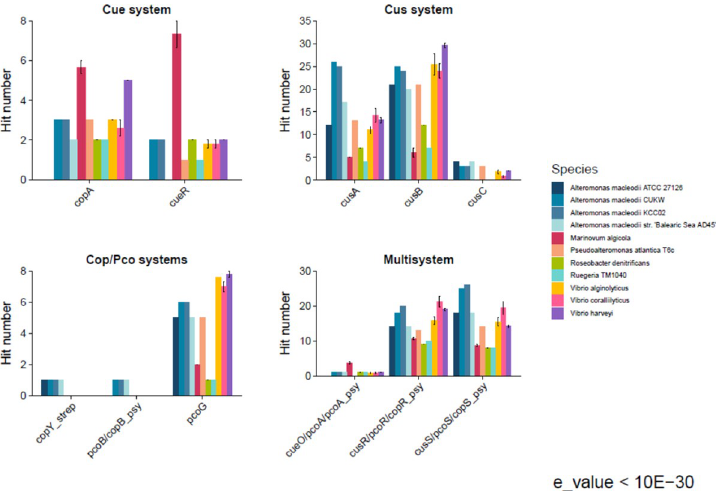
Fig 2. Number of hits to models of copper-associated proteins in CUKW and KCC02 in comparison to other marine bacterial species. Model names are shown on the X-axis. The number of hits per protein and per species were counted and grouped by the category of interest: Cue, Cus, Cop/Pco, and multisystem. An e-value of 10 − 30 served as the threshold for defining a hit.